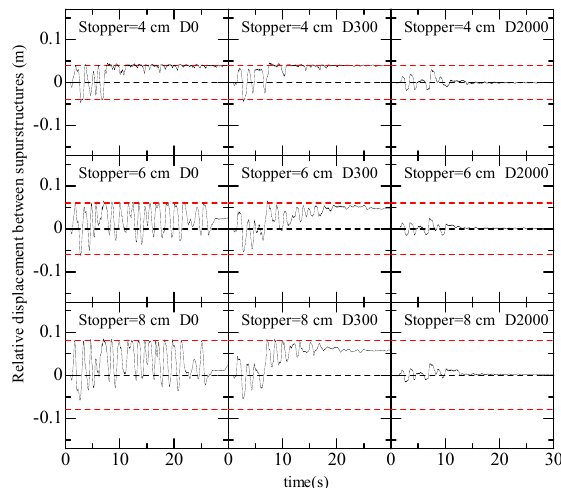
Figure 11. Relative displacement between superstructures.